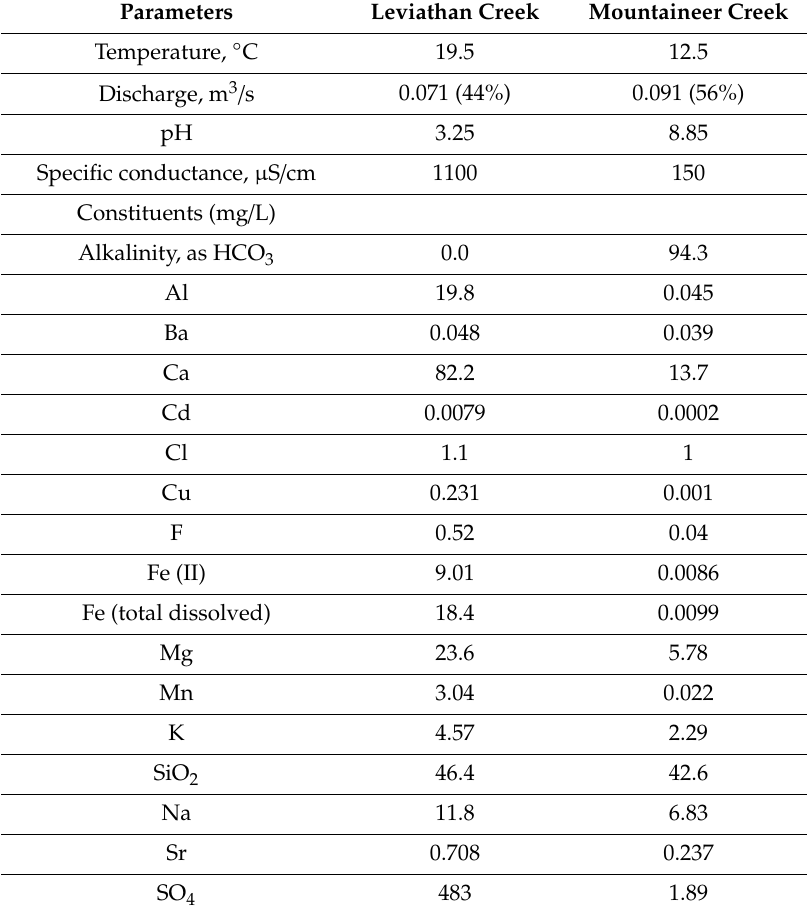
Table 1. Analyses of Leviathan and Mountaineer Creeks collected on 15 June